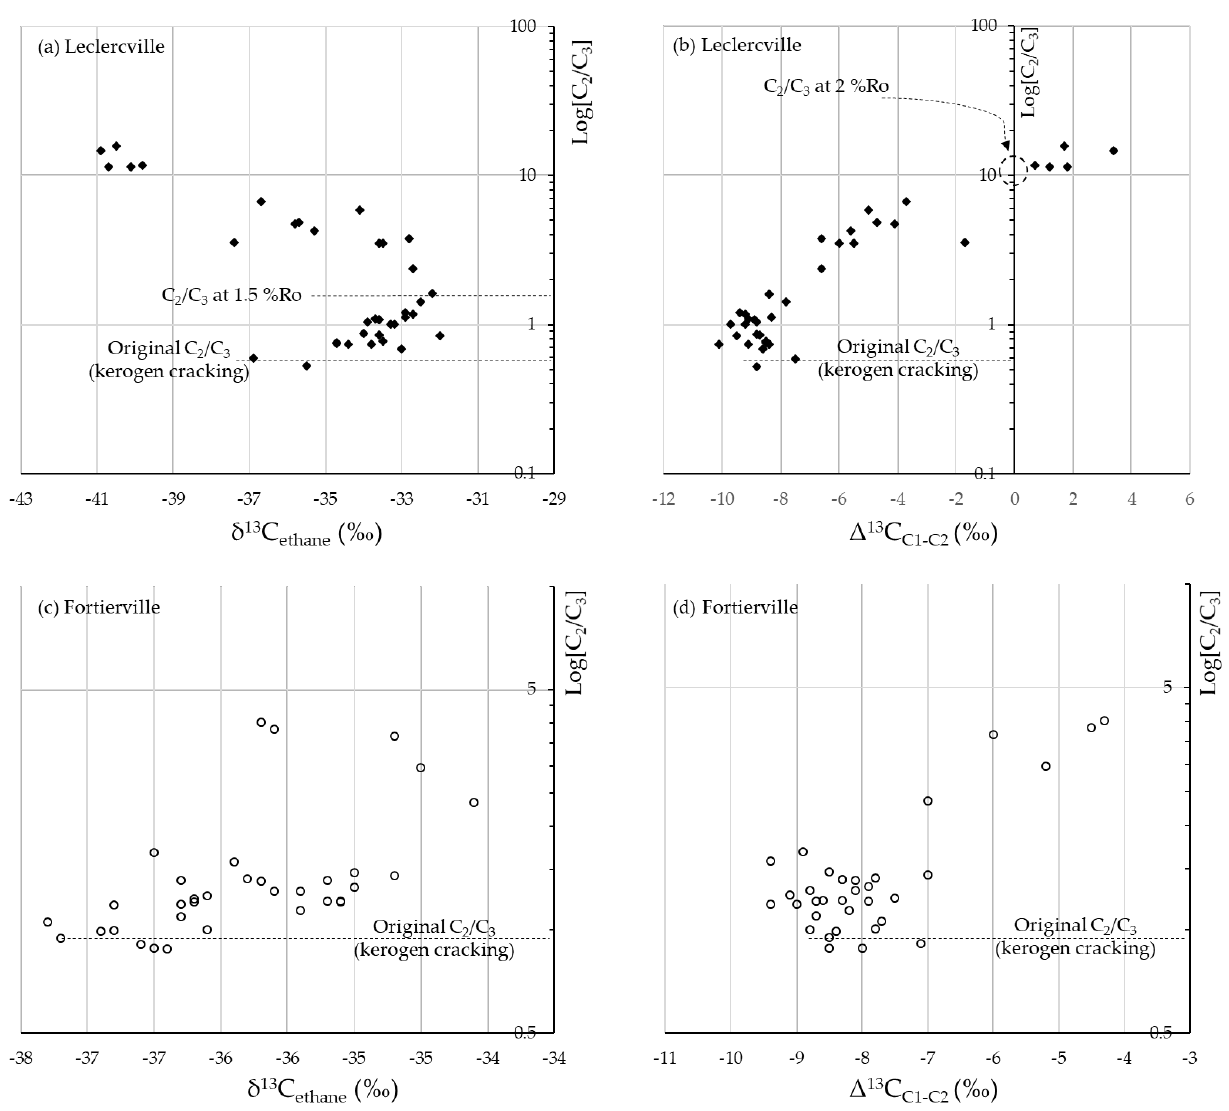
Figure 2. The relationship between the C 2 /C 3 ratio and ( a , c ) the δ 13 C of ethane, and ( b , d ) the Δ 13 C C1-C2 difference; for samples from the Fortierville ( a , b ; circle markers) and Leclercville ( c , d ; square markers) wells in the Lorraine Shale.